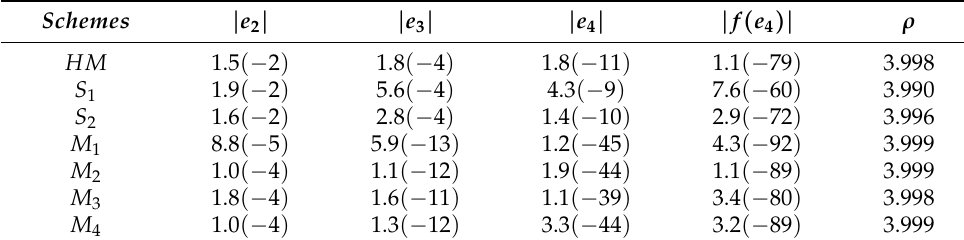
Table 1. Numerical results of function f 1 .